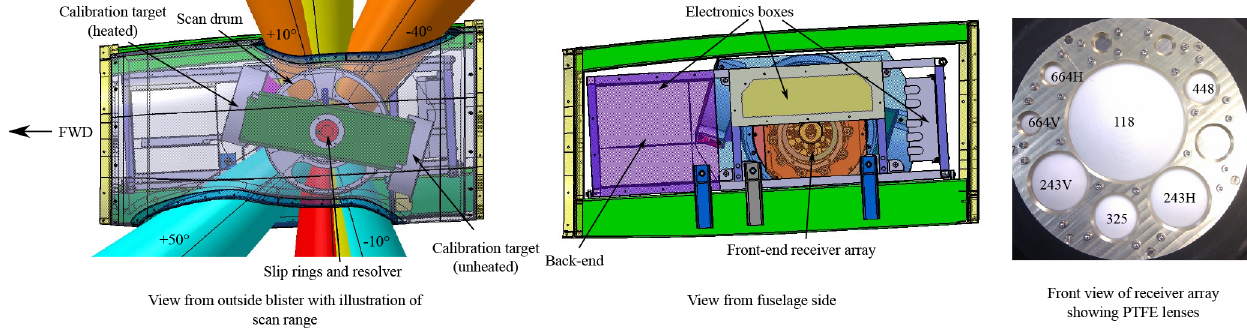
Figure 2. Schematic of ISMAR with illustration of scan range, and image showing the front-end receiver